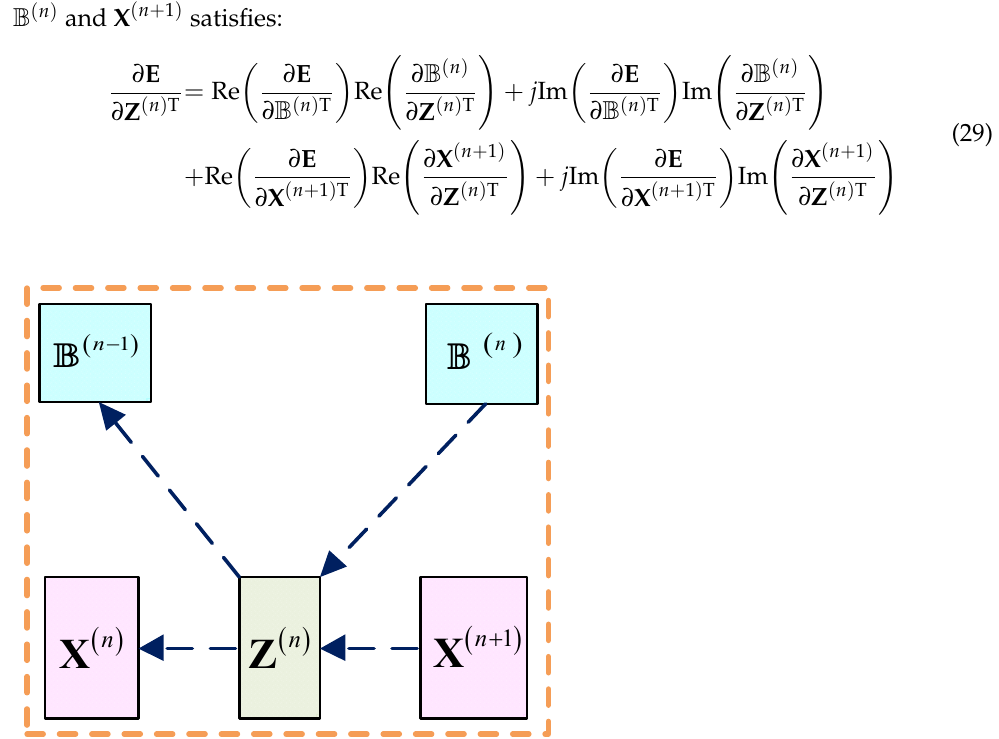
Figure 6. Back-propagation of the nonlinear transform layer. Figure 6. Back ‐ propagation of the nonlinear transform layer. ( n ) The gradient calculations of q , B ( n − 1 ) , and X ( n ) are consistent with the derivation i of the piecewise linear function defined in